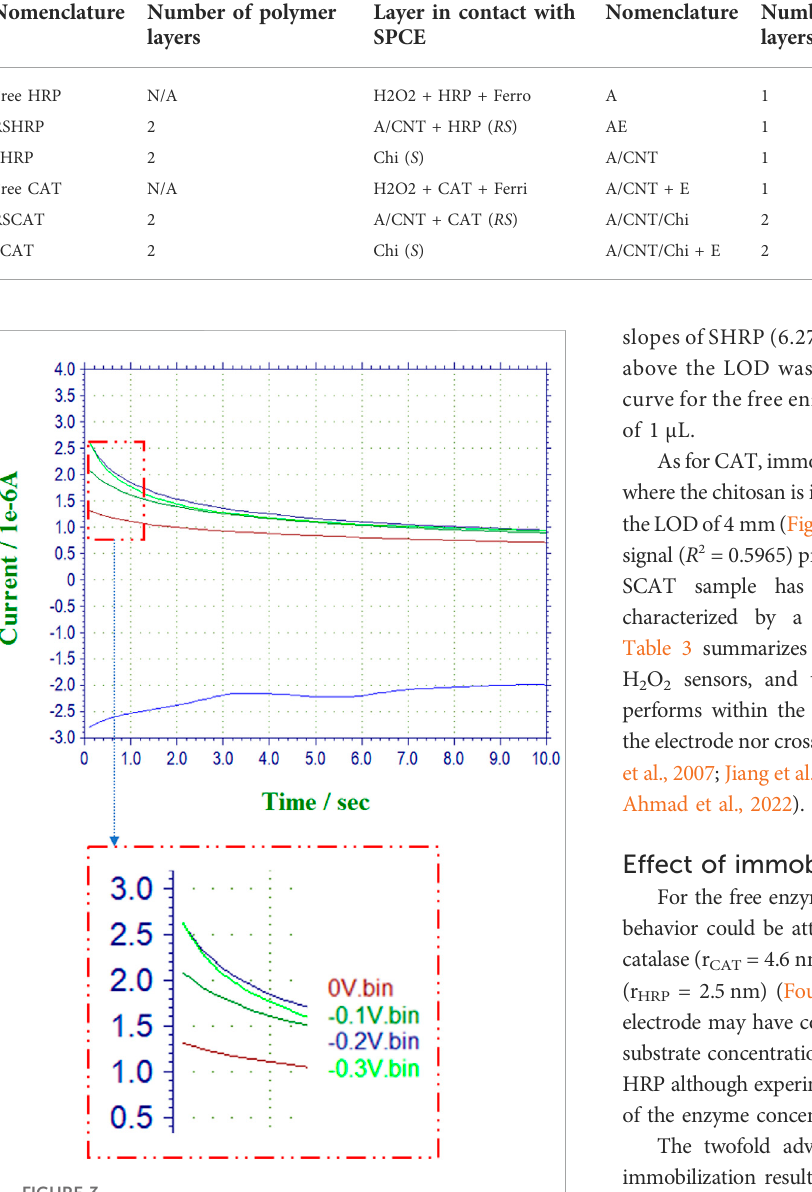
FIGURE 3 (A) (top) Superimposed sample amperograms for Free HRP and 8 mM of H 2 O 2 recorded at multiple voltages for a total scan time of 10 s using which the steady state sampling times were estimated. (B) (bottom) Outset dashed magni fi ed region for the determination of the maximum current (I max@S ) used for the signal to noise